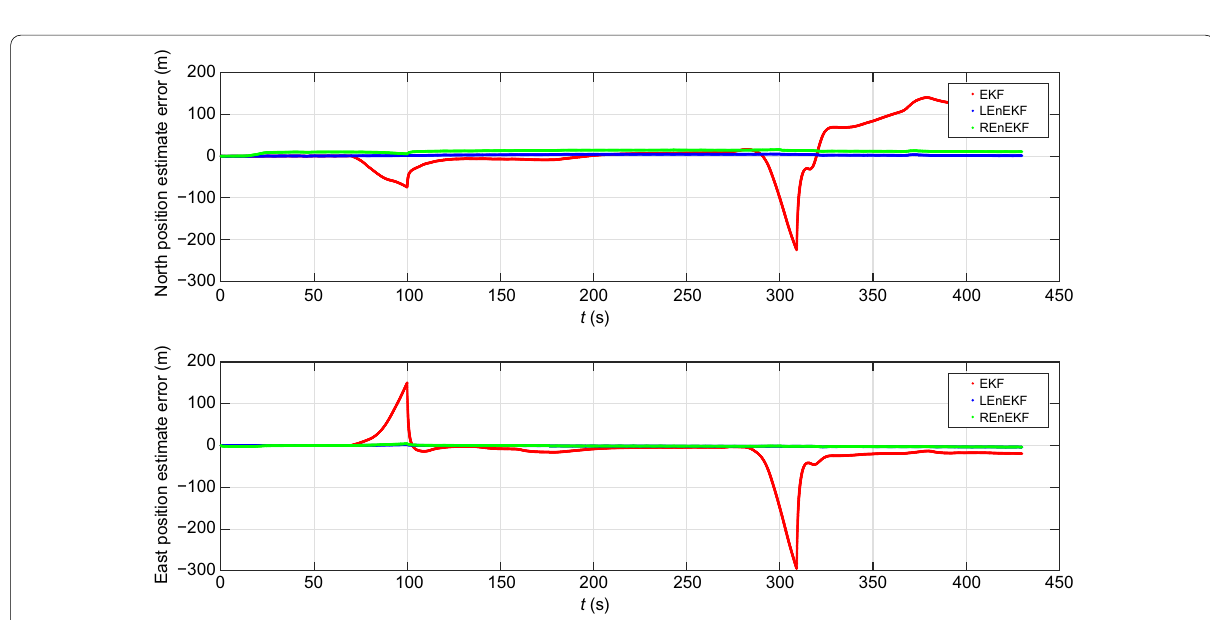
Fig. 4 Position errors of two 30s GPS outages